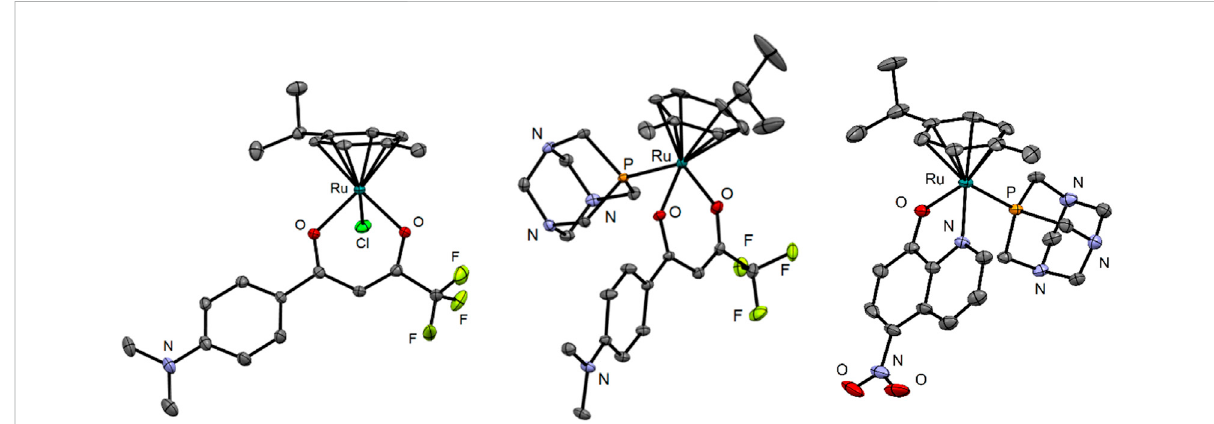
Crystal structures of compounds 3 , 4 , and 10 . The ellipsoids are drawn at 35, 25, and 35% probability levels, respectively. The hydrogen atoms and the PF 6 – counterion in the structures of 4 and 10 as well as the diethyl ether solvate in 10 are omitted.